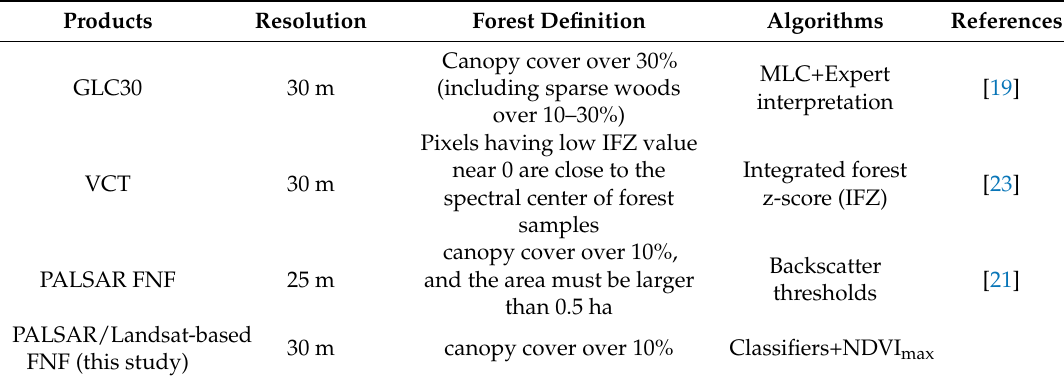
Table 3. Summary of the forest cover products used.